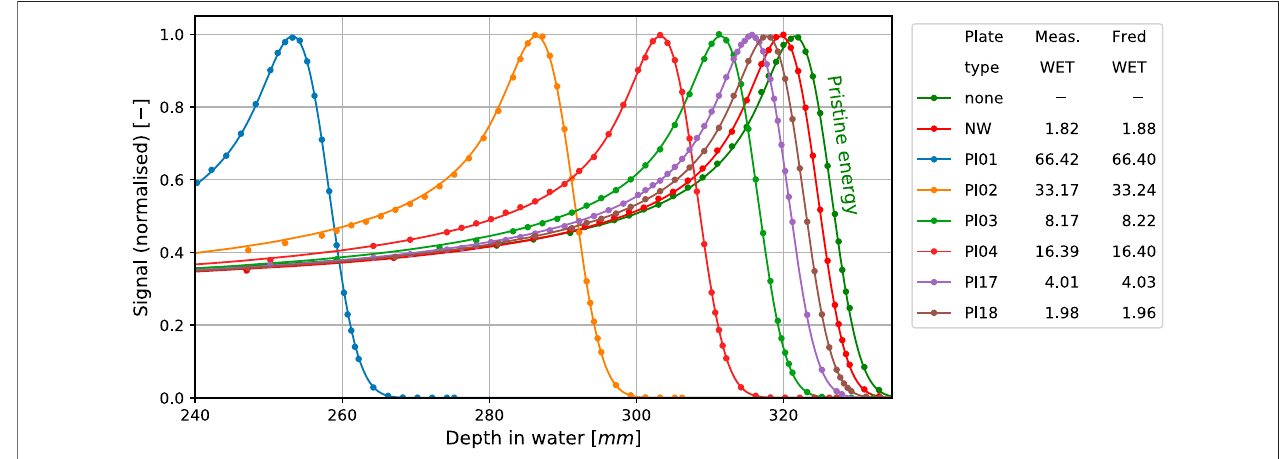
FIGURE4| Measured (dots)andsimulated(solidlines)BPsforselectedRSplatesandthenozzlewindow (NW)WETcompared totheBPofpristineenergy.Allthe simulation results account for the geometrical acceptance correction for the BPC. The table presents calculated and measured WET in mm.